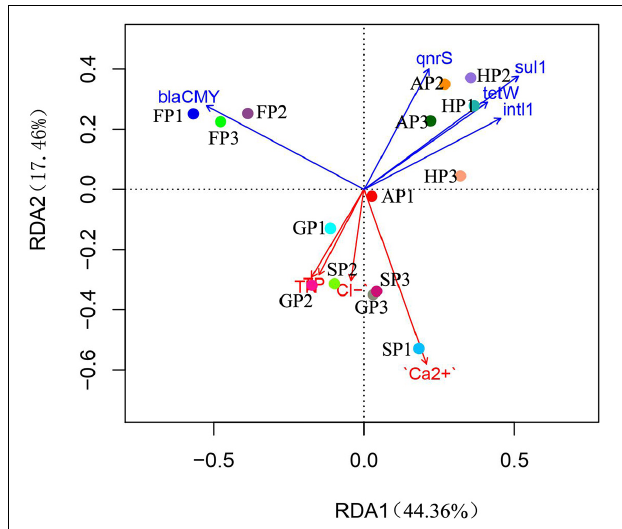
FIGURE 4 | The redundancy analysis (RDA) of environmental factors, antibiotic resistance genes (ARGs), and bacterial